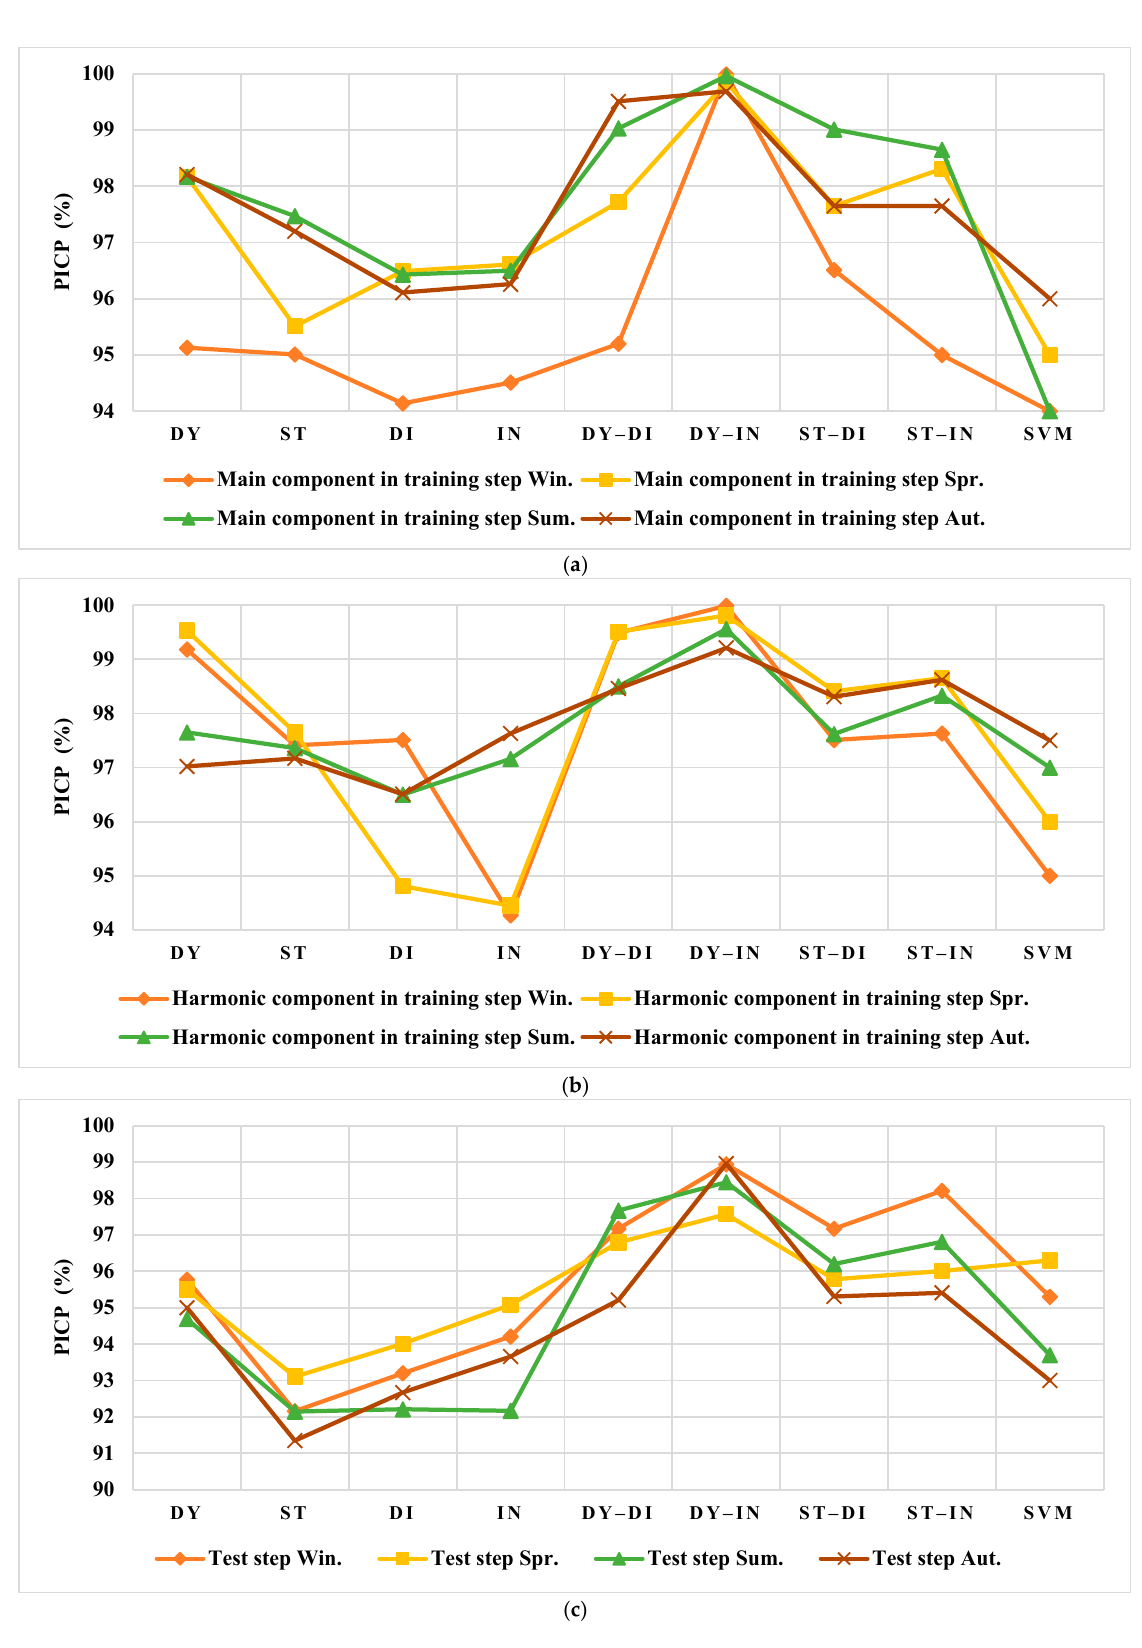
Figure 19. The results of PICP (%) for the US: ( a ) Main Component in training step, ( b ) Harmonic Component in training step, ( c ) Test step